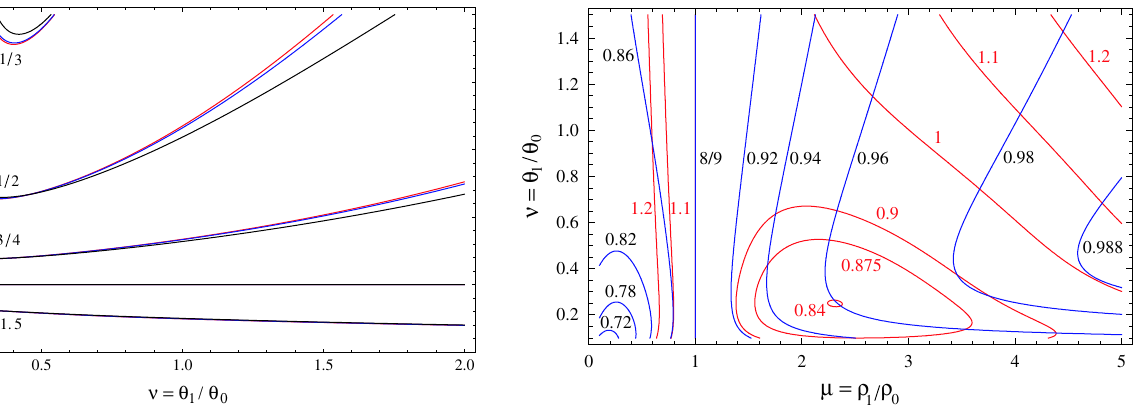
FIG. 2. (Color) Contours of the ratio of the absolute minimum emittances in a sandwich dipole to that in a uniform dipole of the same bending angle. The red curve is the approximation given by Eq. (46). The blue (black) curve is the exact result corresponding to a total bending angle of (cid:15)= 5 ( (cid:15)= 2 ).